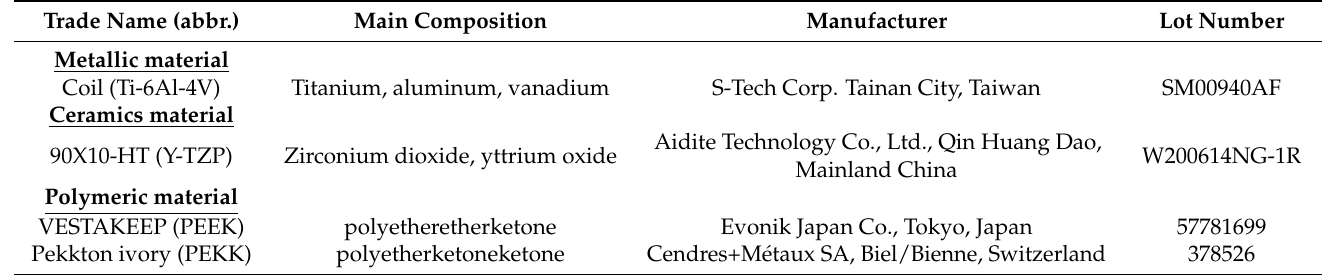
Table 1. Material assessed in the present